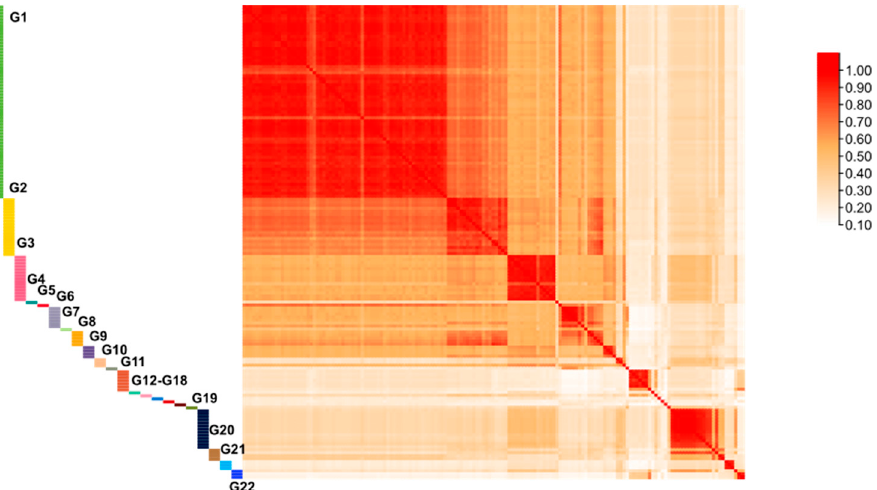
Figure 3. The heatmap of the GS values of pairwise comparison between 22 pedigrees and all cultivars.